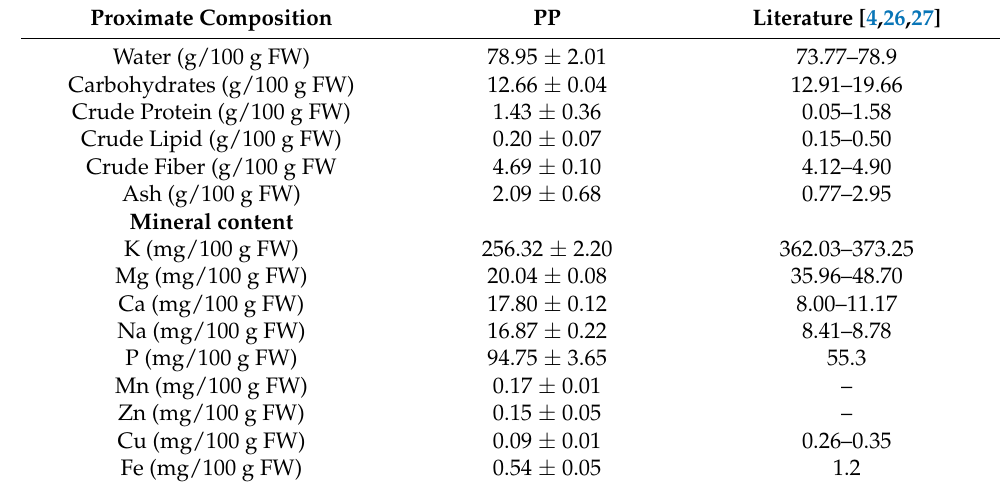
Table 1. Nutritional properties of P. peruviana from the Arid Andean Region of Chile. Proximate Composition PP Literature [4,26,27] Water (g/100 g FW) 78.95 ±